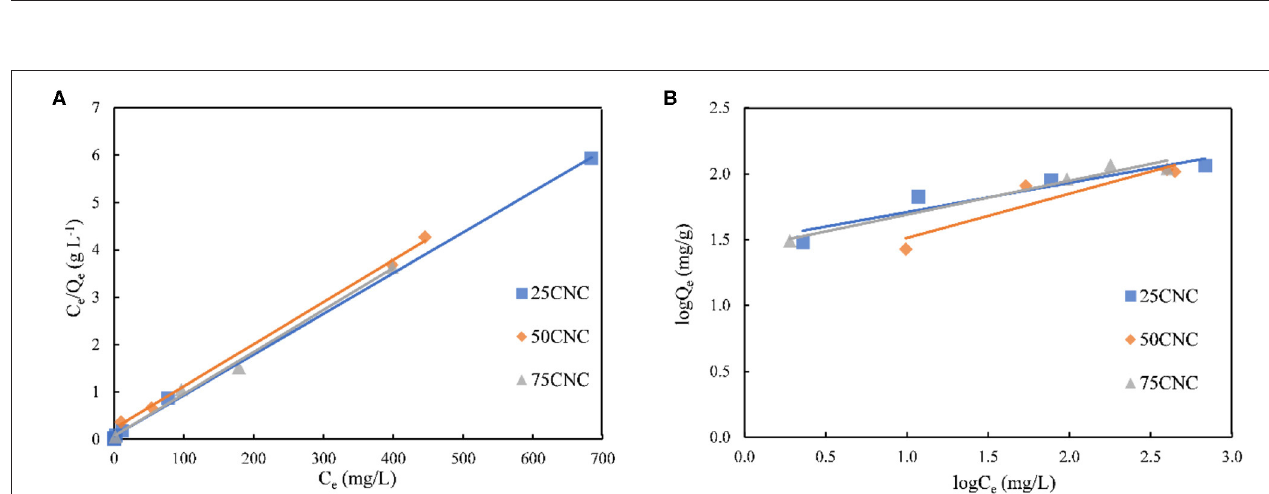
FIGURE 5 | The linear fit of Langmuir model (A) . The linear fit of Freundlich model (B) .